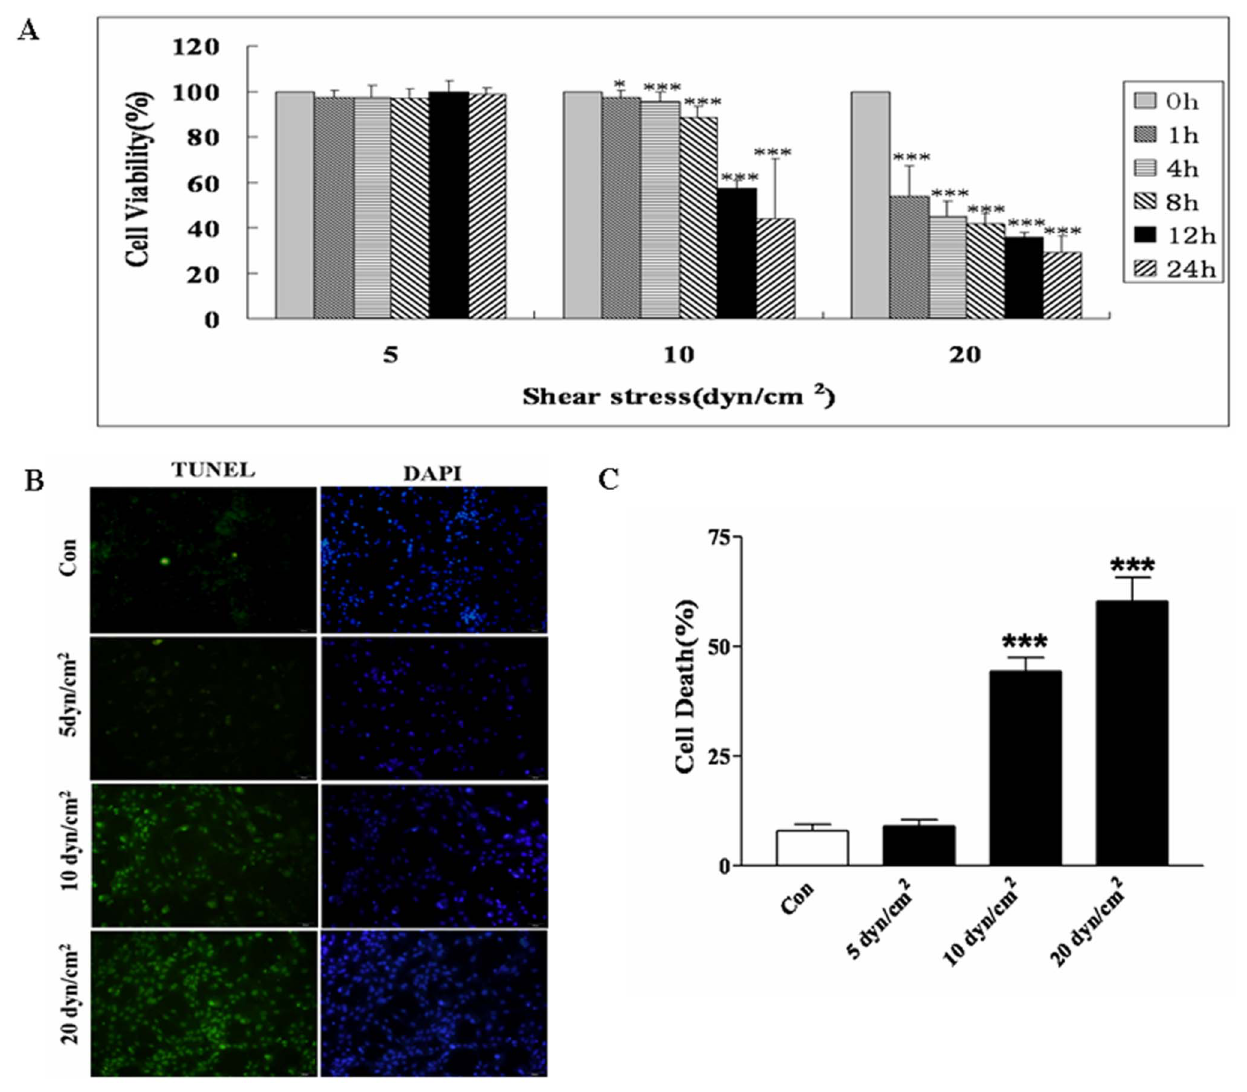
Figure 1. Effect of shear stress on primary cultured cortical neurons. A) Histograms show that the cell viability decreases significantly after shear stress of 5, 10, 20 dyn/cm 2 for 1 h, 4 h, 8 h, 12 h and 24 h respectively by MTT assay. B) Photomicrographs and C) histograms show that as shear stress levels increased (from 5, 10 dyn/cm 2 to 20 dyn/cm 2 ) TUNEL positive cells increased significantly by TUNEL assay. * p , 0.05, ** p , 0.01 and *** p , 0.001 were considered to be statistically